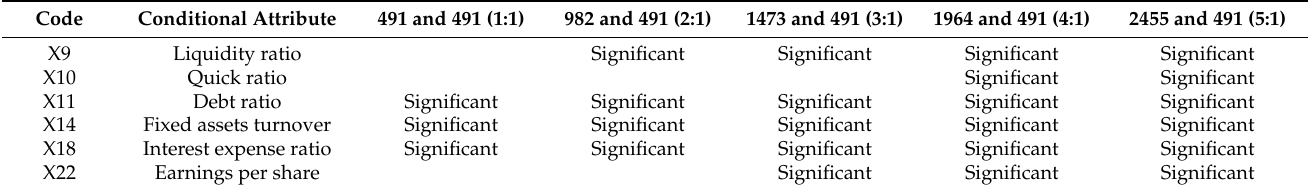
Table 23. Results of DT analysis for normal vs. bankrupt.